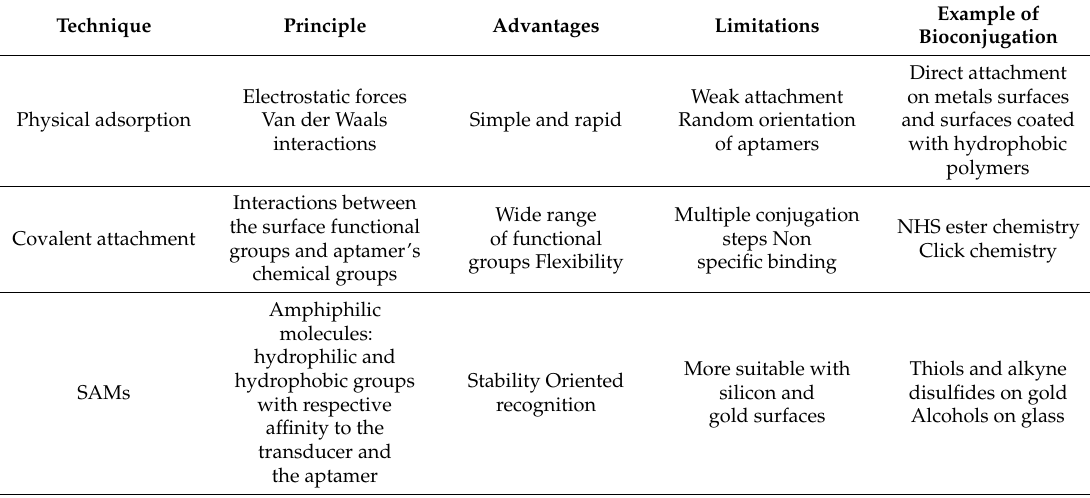
Table 1. Different types of aptamer immobilization techniques for aptasensor